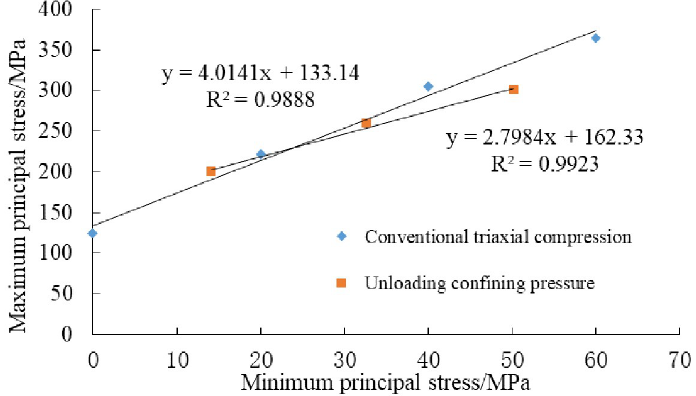
Fig 5. Stress-strain curves of shale samples under different stress paths.